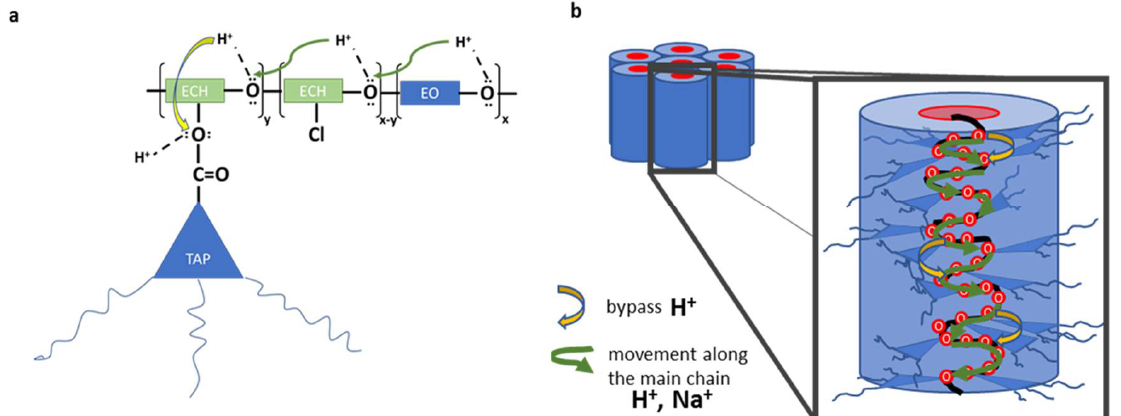
Figure 7. Raman spectra of CP36 in 0.1 M NaCl before, during, and after transport experiment: full range ( left site ) and onset of changed region ( right site ).